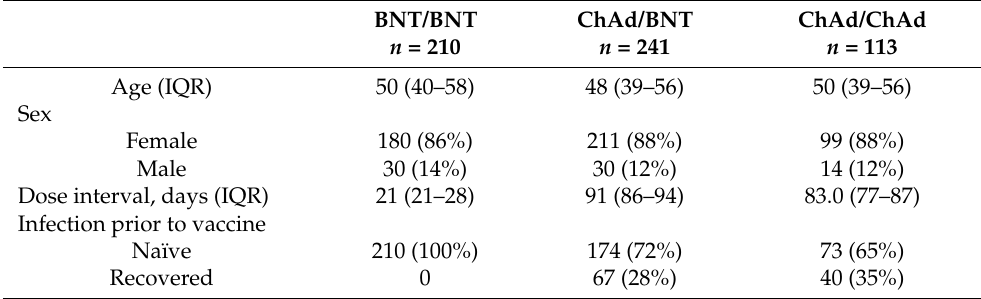
Table 1. Demographics, vaccine dose interval and occurrence of SARS-CoV-2 infection prior to vaccination. BNT; BNT162b2 mRNA vaccine, ChAd; ChAdOx1 nCoV-19 vaccine, IQR; interquartile range. Age and dose interval are presented as median (interquartile